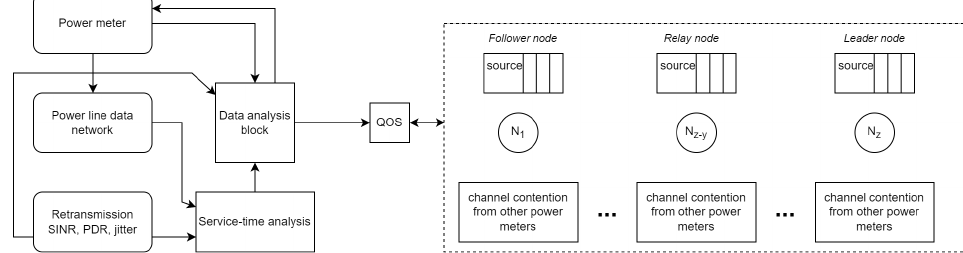
Figure 1. Data analysis flow